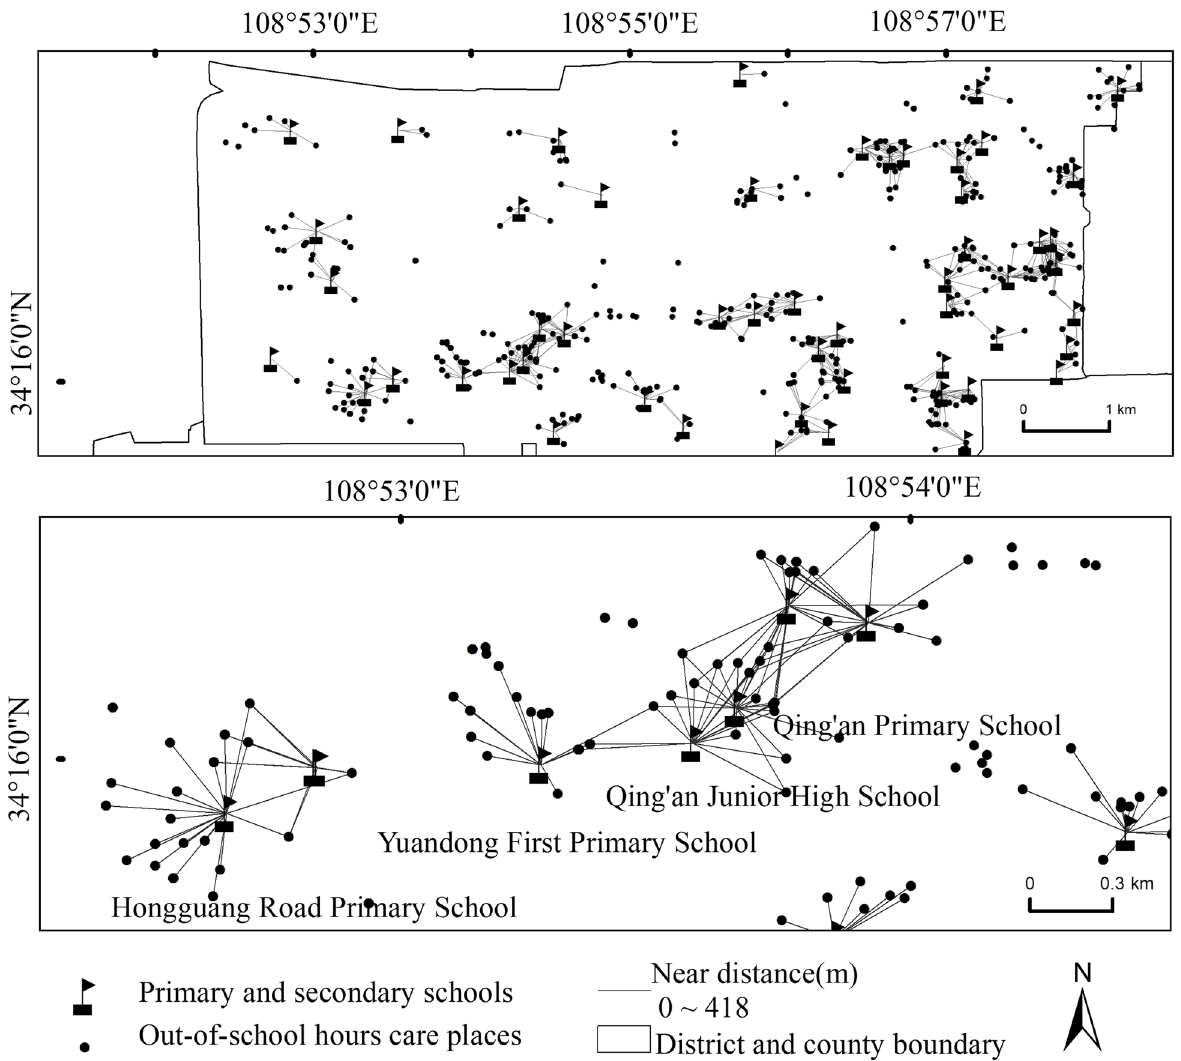
Fig. 5 OD analysis map of Lianhu District, Xi’an